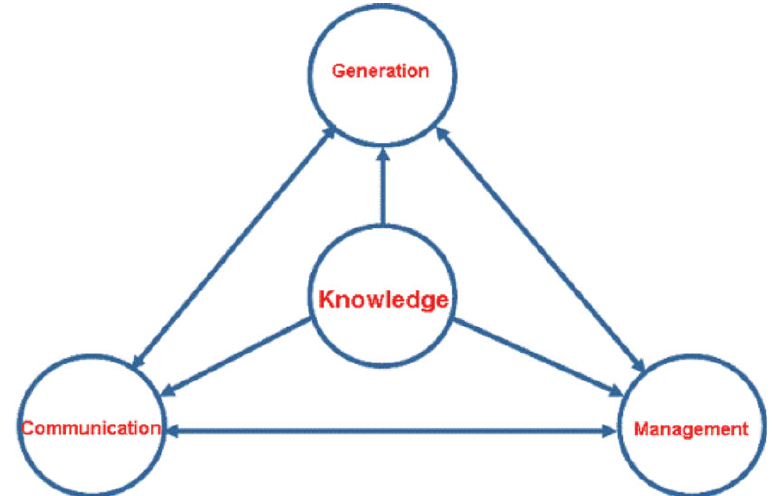
(Colour online) A model of knowledge